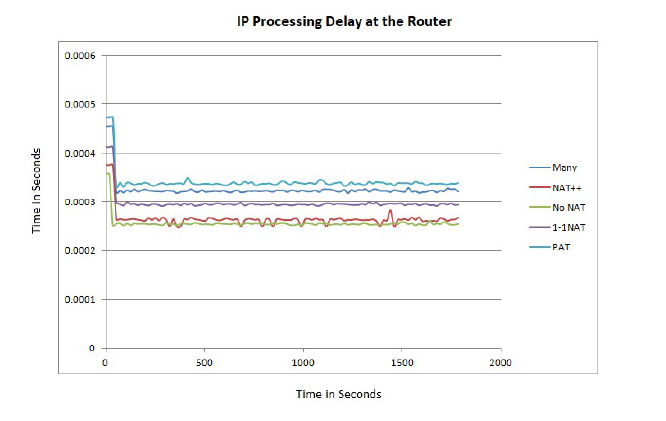
Figure 11. IP Processing delay.